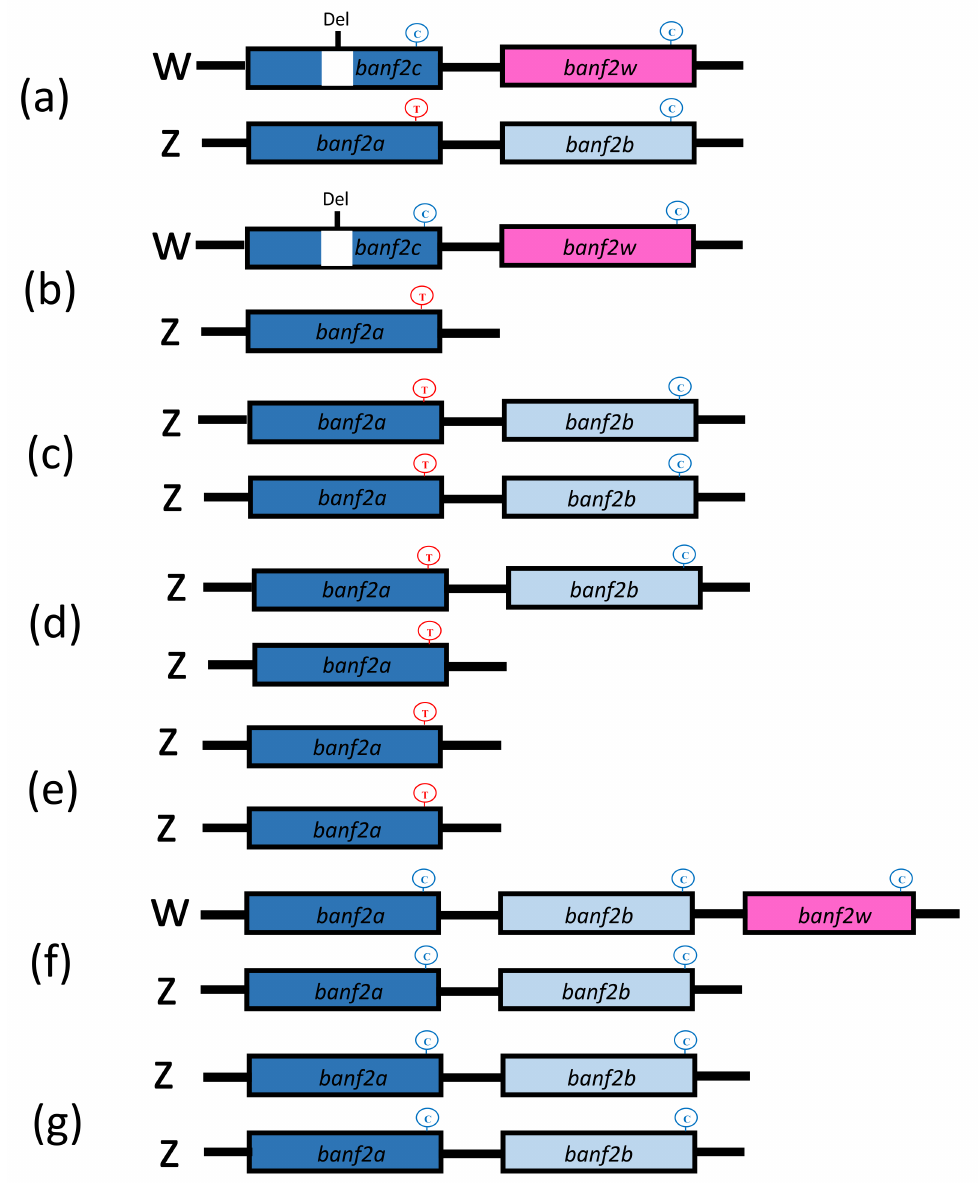
Figure 3. Suggested schematic models depicting the copy number variation of banf2 genes in the LG3 sex-determining loci of cichlid fish. Models include delineations for banf2 genes that are not sex-specific (blue boxes) and for the female determination genes (pink boxes). Gene models of banf2 for females ( a , b ) and males ( c – e ) demonstrate variability within the Oreochromis aureus ( Oa ) hybrid stock and homogeneity of purebred Oa females ( b ) and males ( e ). The simplest gene model was observed for the banf2 locus of both sexes of O. niloticus ( e ). A five-copy model represents the gene arrangement predicted for both O. tanganicae and O. urolepis hornorum females ( f ), and a four-copy model that of males of these species ( g ). “Del” represents a large deletion in banf2c intron used as a genetic marker in Oa . Shown in circles, an informative C/T/G SNP in exon 3 of banf2 genes was used to resolve the models in a peak-ratio analysis of Sanger sequencing (also highlighted by red dots in Figure